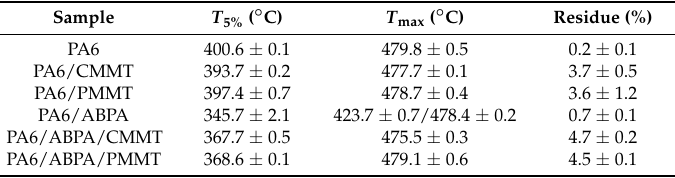
Table 2. Thermal properties of PA6 and PA6 composites under nitrogen